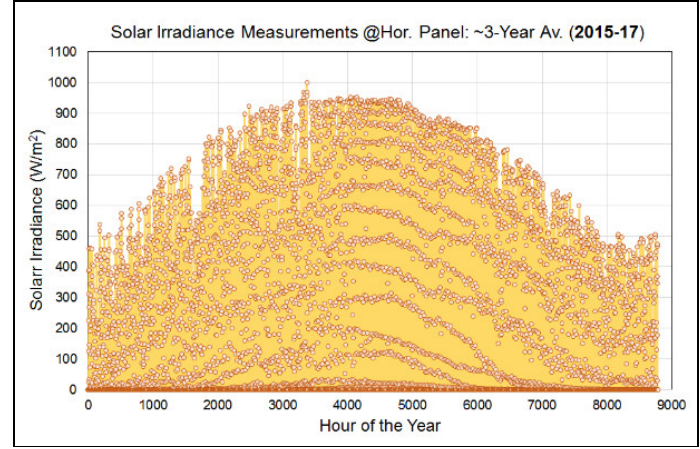
Figure 6. Solar irradiance time series at horizontal plane for Tilos island.